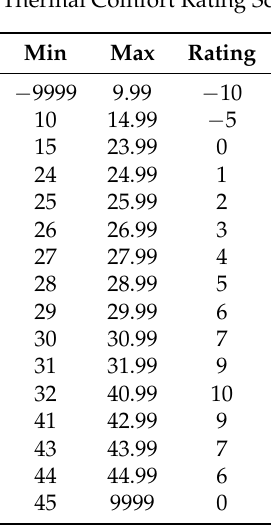
Table 4. Humidex-based Thermal Comfort Rating Scheme of HCI:Beach-Med.